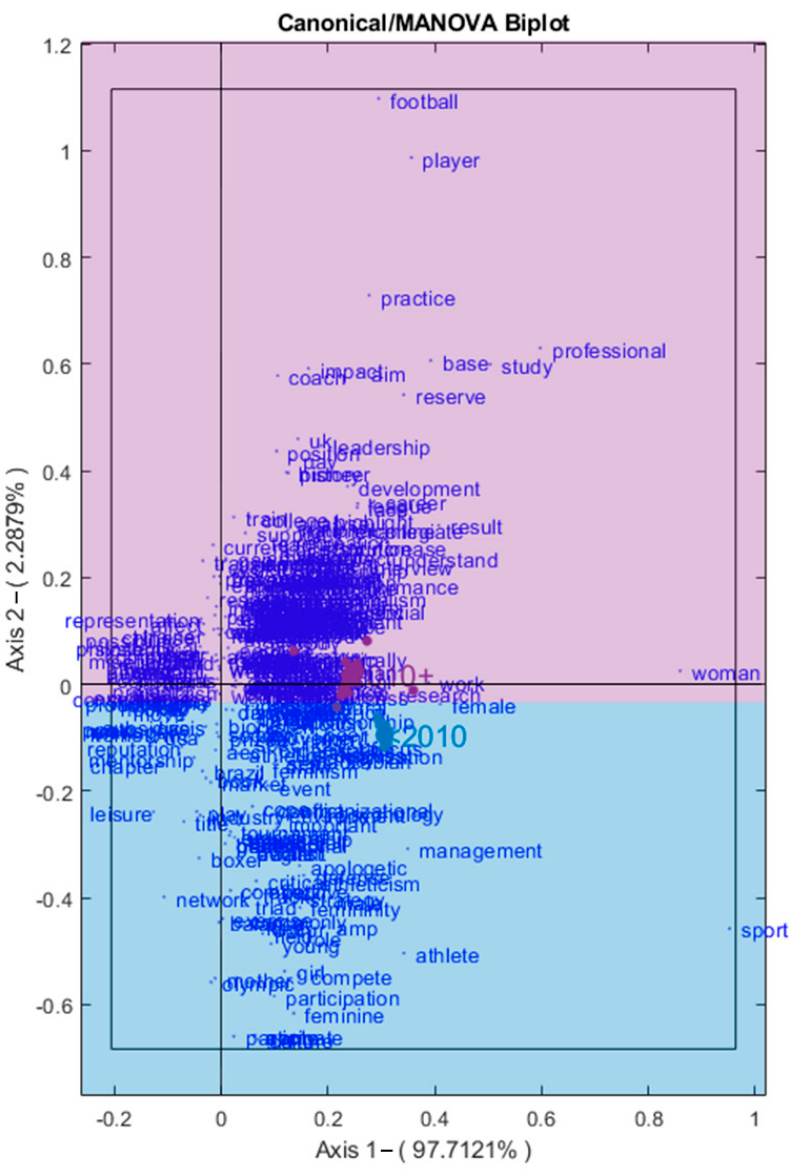
Figure 8. MANOVA Biplot for the SLR of the professionalization of women’s sport.